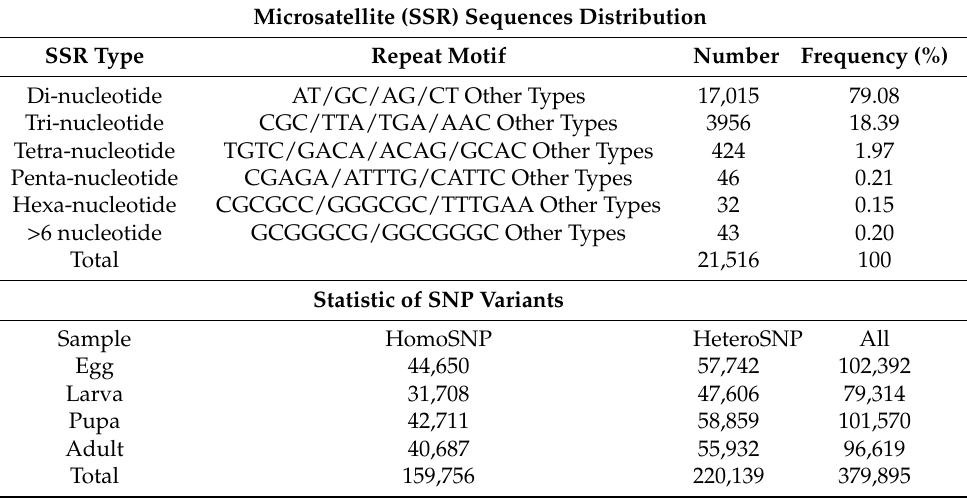
Table 3. Summary of microsatellite and single nucleotide polymorphism distribution in M. plana